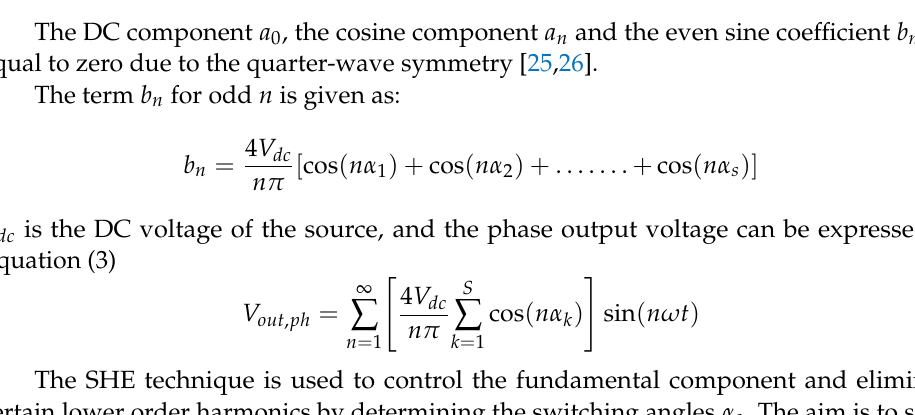
Figure 2. Representing the redundant switching states with output voltage levels.